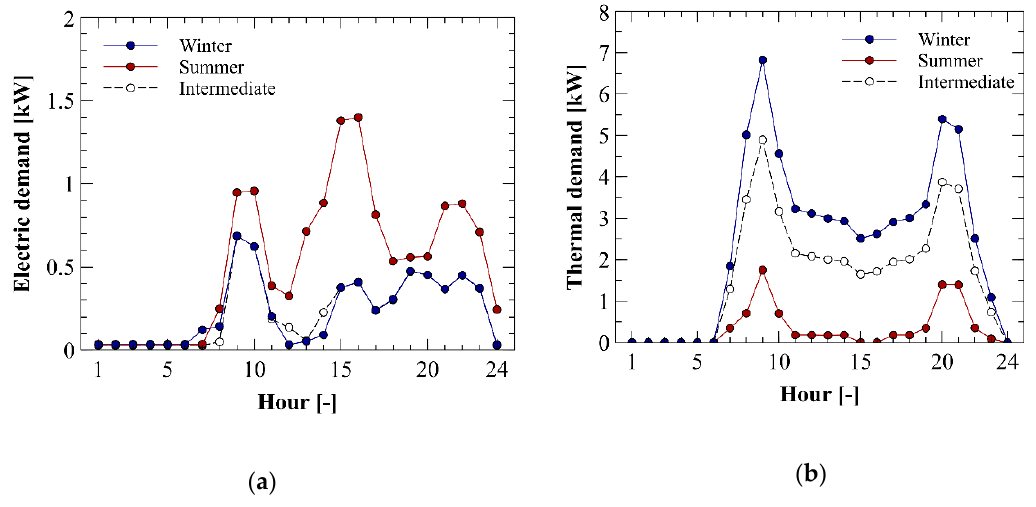
Figure 5. Daily profiles of electric ( a ) and thermal ( b ) power request of a single dwelling during a typical day in winter, summer and intermediate seasons in Southern Italy.